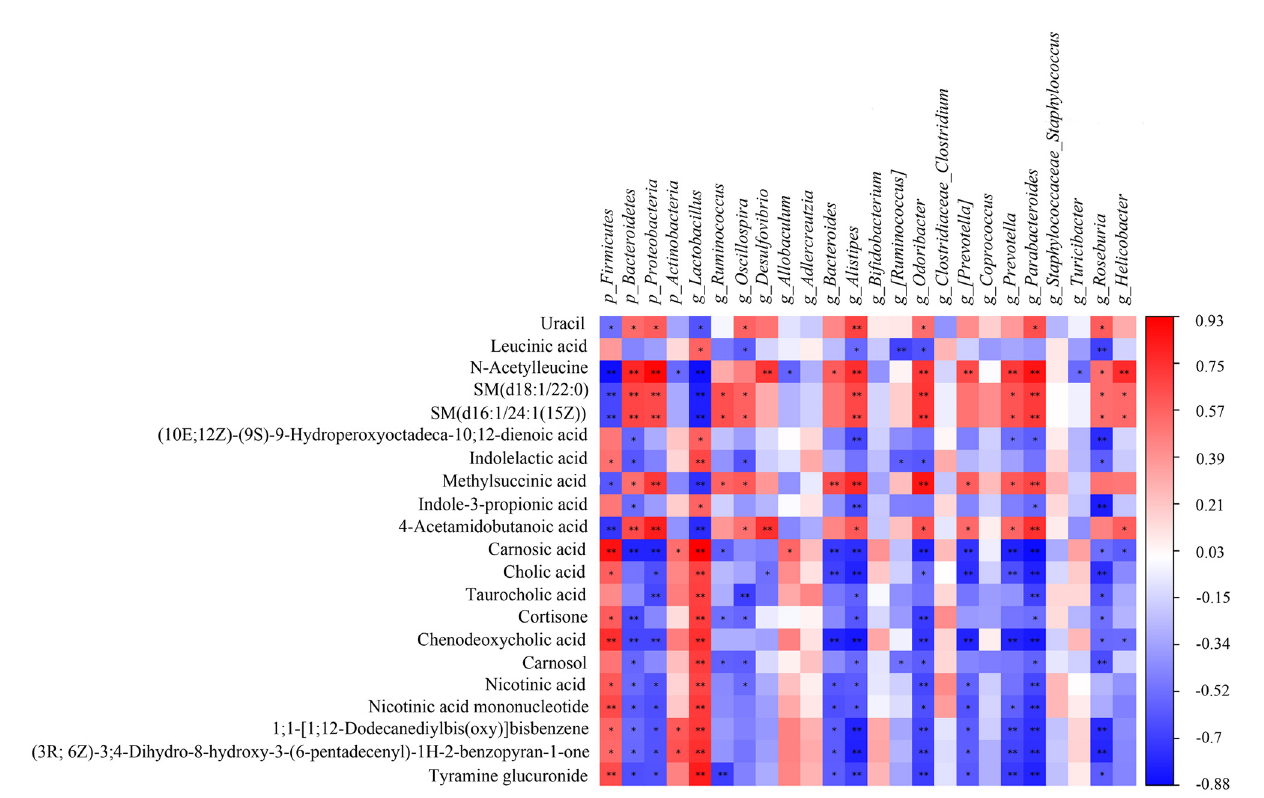
FIGURE9 The Spearman correlation analysis of the gut microbiota and serum metabolites. Correlation between the predominant gut microbiota and metabolites at phylum and genus levels among CK, AM and KFP-M groups. The correlation or difference between groups with significance was represented as ** p < 0.01 and * p < 0.05. CK, control group; AM, acrylamide model group; KFP-M, medium-dose KFP group. Each group consisted of five